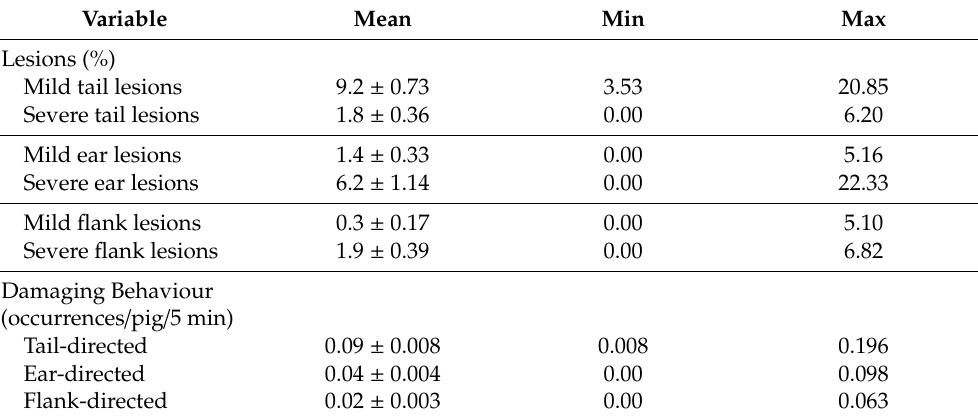
Table 1. Average prevalence (mean ± SE) and range (min–max) of lesions and average frequency of damaging behaviours / pig / 5 min observation expressed by finisher pigs on 31 farrow-to-finish pig farms based on raw